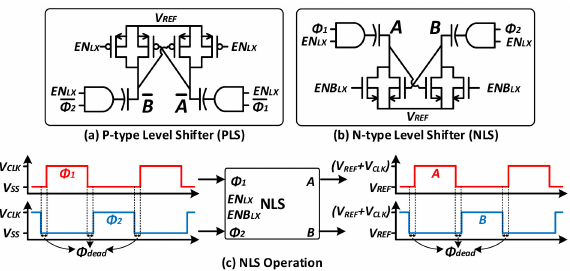
Figure 13. Cross coupled level shifter for gate diving ( a ) P-type level shifter (PLS). ( b ) N-type level shifter (NLS). ( c ) N-type level shifter